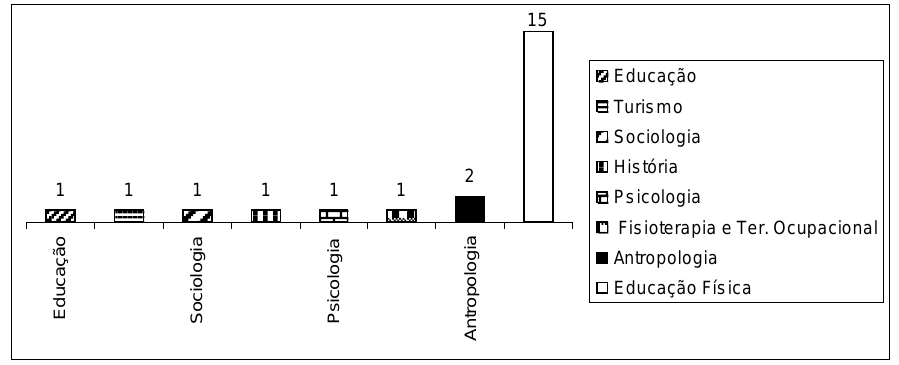
Figura 2. Distribuição dos grupos de pesquisa por área de